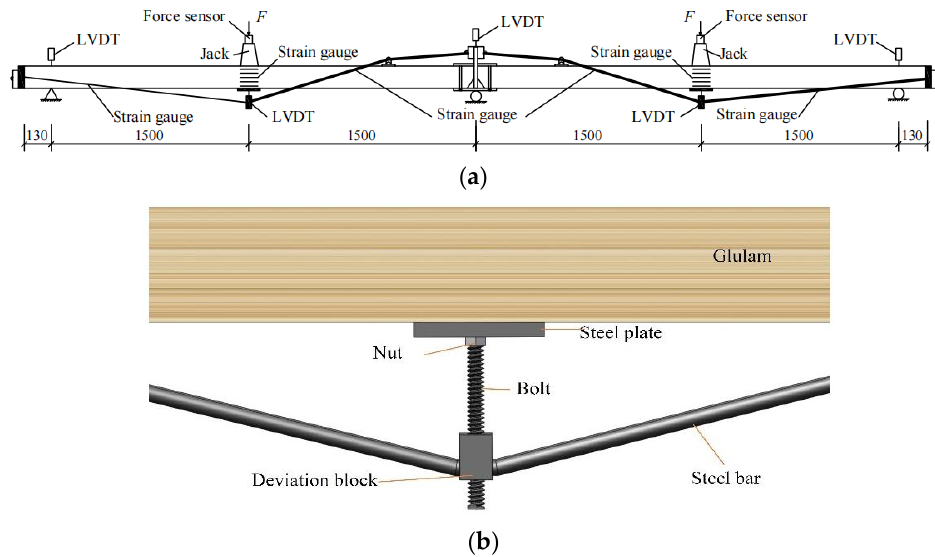
Figure 2. Schematic diagram of specimen. ( a ) Schematic diagram of glulam continuous beam; ( b ) Schematic diagram of prestressed apparatus.